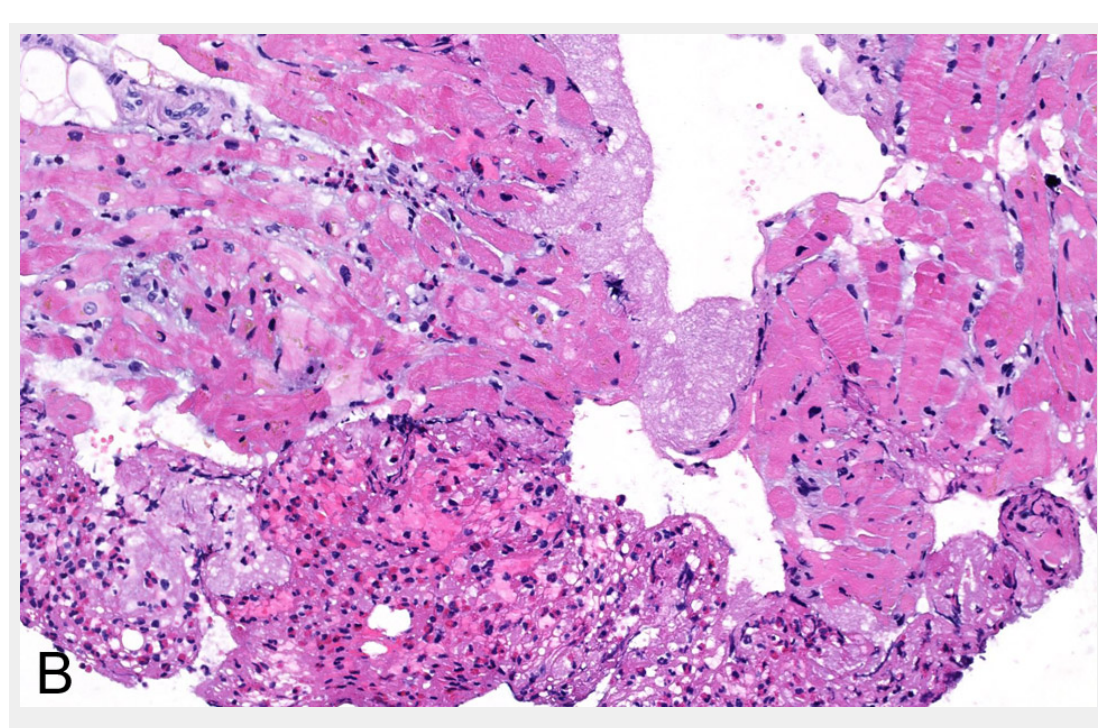
Figure 3B Fibrinous thrombotic material mixed with numerous eosinophils was attached To the endocardium (H&E stain,